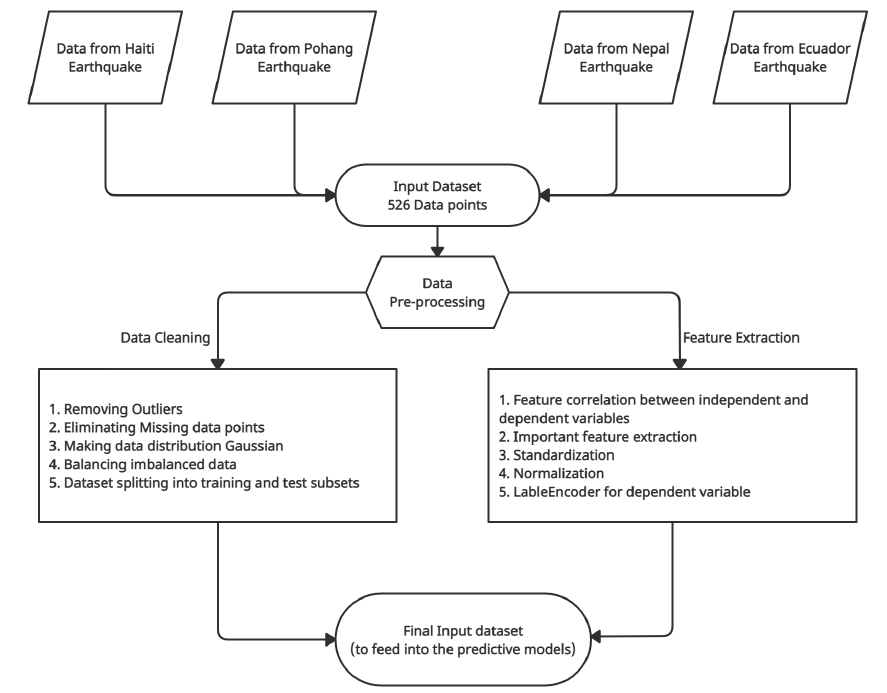
Figure 1. The workflow of data preprocessing for feeding data to predictive